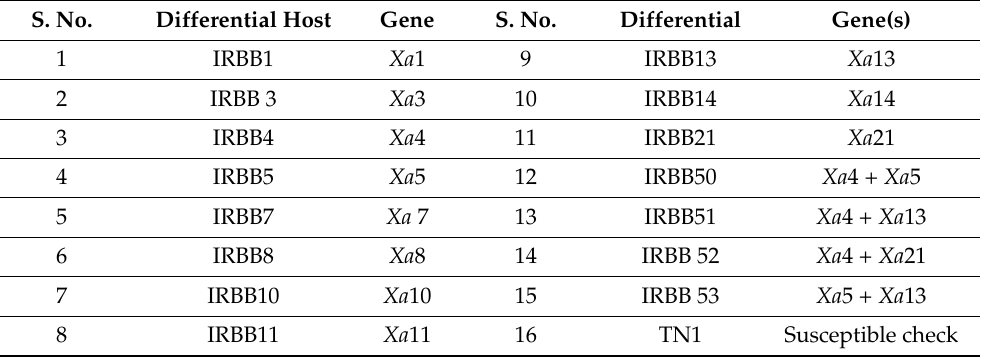
Table 1. List of differentials used for studying virulence dynamics of Xanthomonas oryzae pv. oryzae . S.